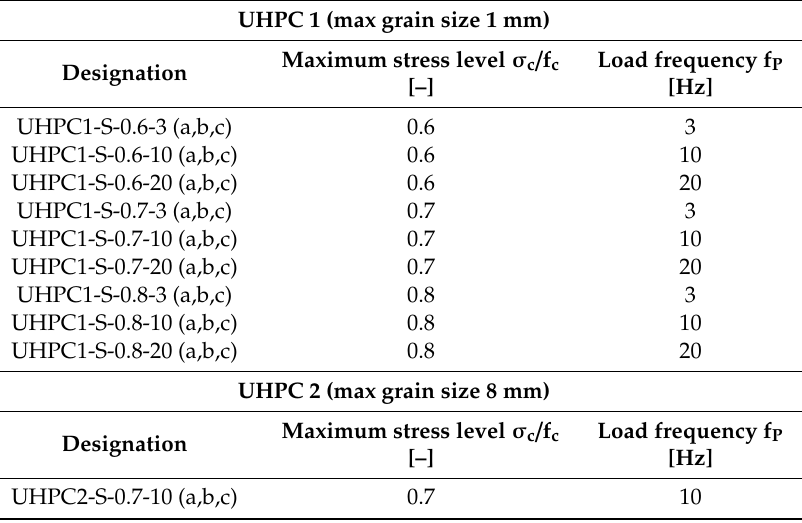
Table 1. Experimental